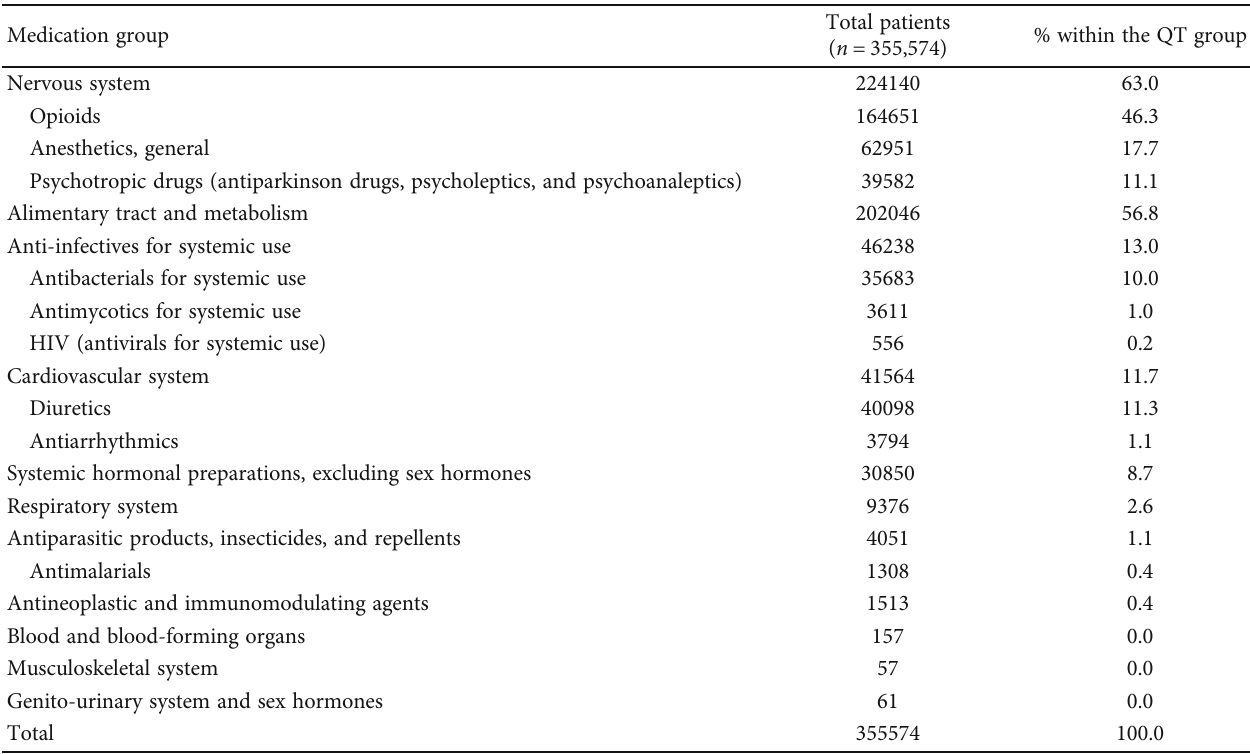
Table 2: Distribution of use of each pharmacological group of QT-prolonging